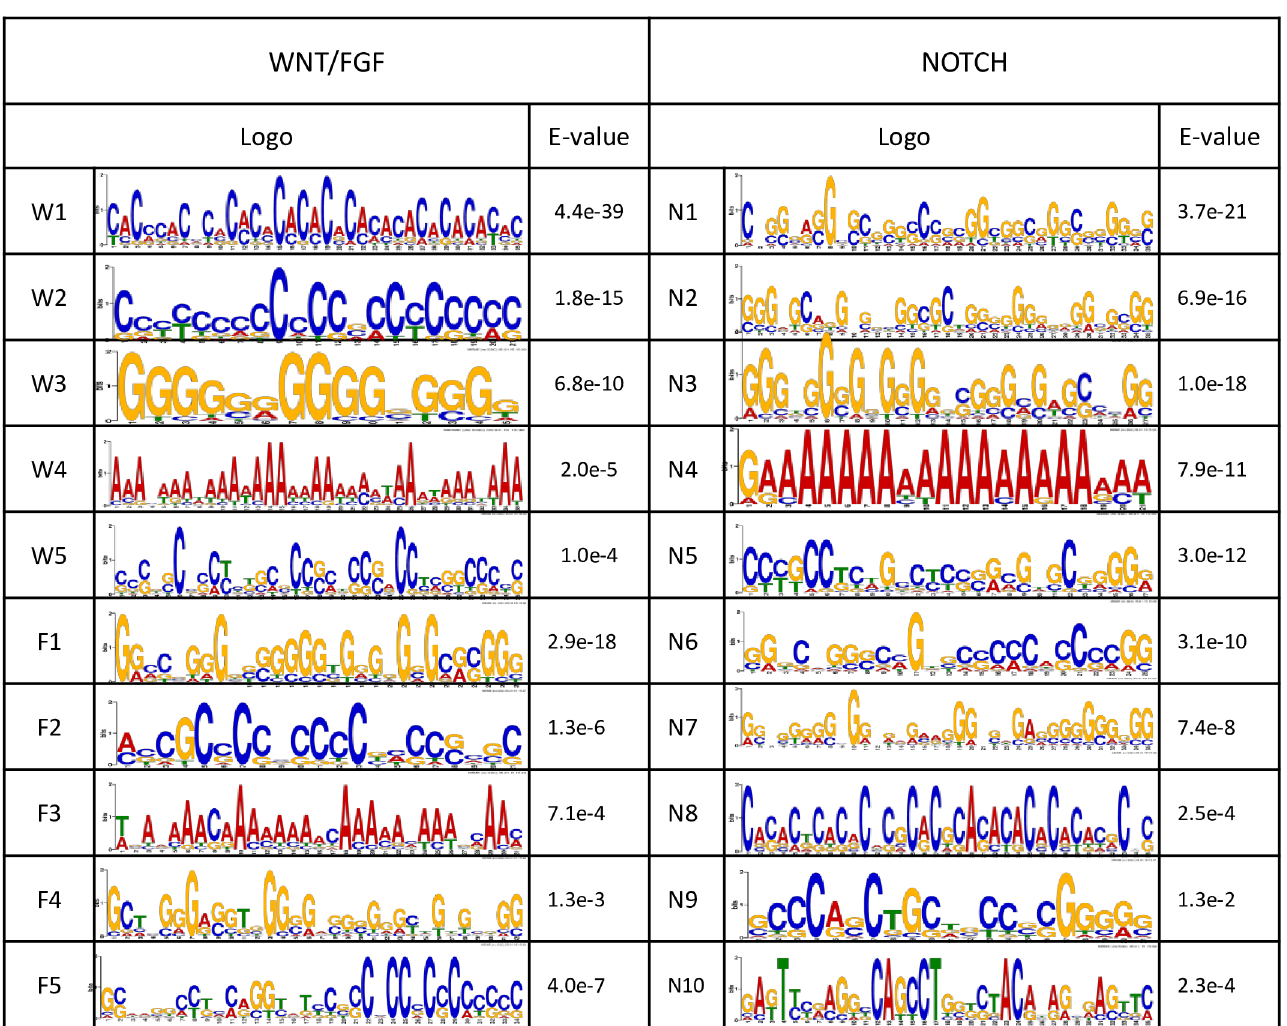
Fig 5. De novo motif discovery led to 20 statistically significant motifs overrepresented in the promoter regions of mouse cyclic genes. We found 10 motifs (named N1-N10 ) in the promoter region of Notch cyclic genes, 5 motifs for Wnt cyclic genes ( W1-W5 ) and Fgf cyclic genes ( F1-F5 ). The motifs were ruled significant after passing all steps described in the Methods